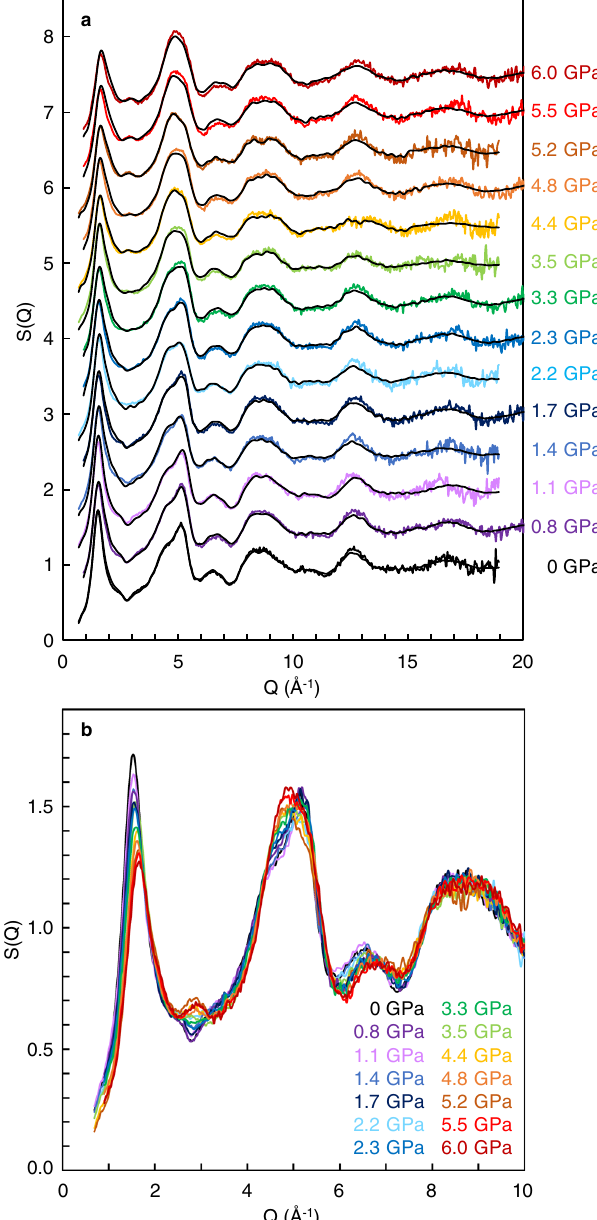
Fig. 1 Structure factor [S(Q)] of SiO 2 glass at high pressures. a Color lines represent experimentally observed S(Q), and black lines show S(Q) of the MD-RMC structure model derived based on the experimentally observed S(Q) at each pressure condition. S(Q) is displayed by a vertical offset of + 0.5 with increasing pressure. b Enlarged view of the experimentally observed S(Q) at the Q range between 0 and 10 Å − 1 . S(Q) is displayed without vertical offset. There are clear changes in the oscillations at ∼ 2.9 and ∼ 5 Å − 1 with increasing pressure. z = δ ji − δ j ’ i , where δ ji and δ j ’ i is the distance from each silicon atom i to the fi fth nearest silicon neighbor j and to the fourth nearest oxygen neighbor j ′ , respectively. Figure 2 shows the